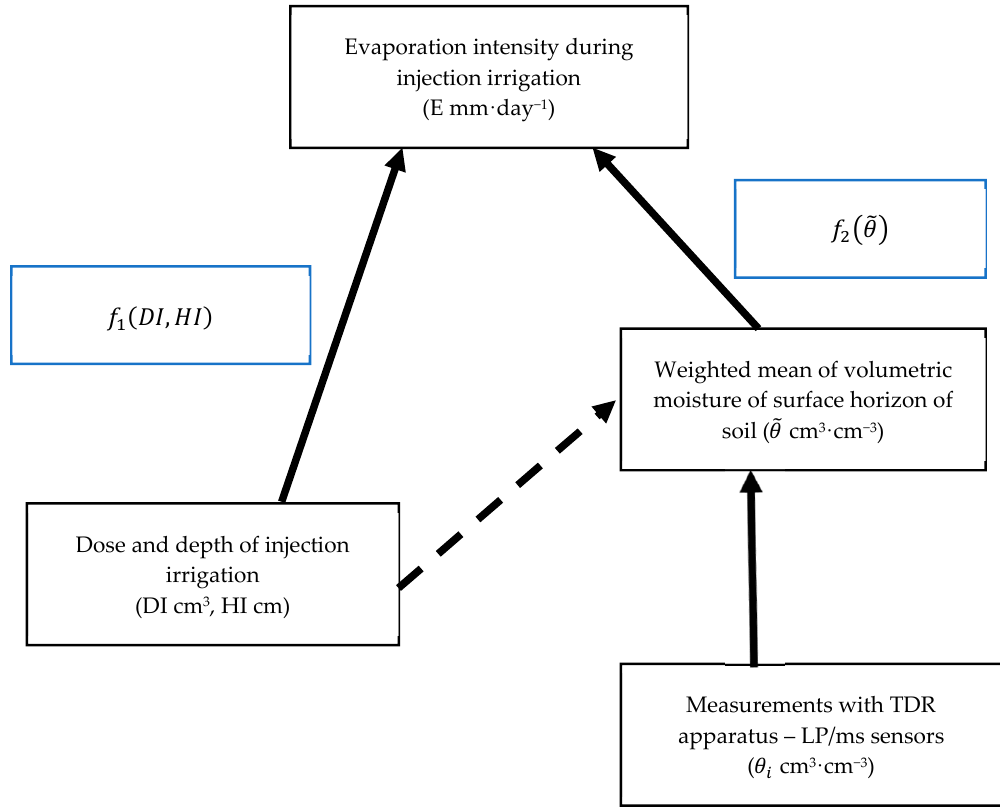
Figure 1. Input data for functions approximating evaporation intensity in the conditions of injection irrigation.